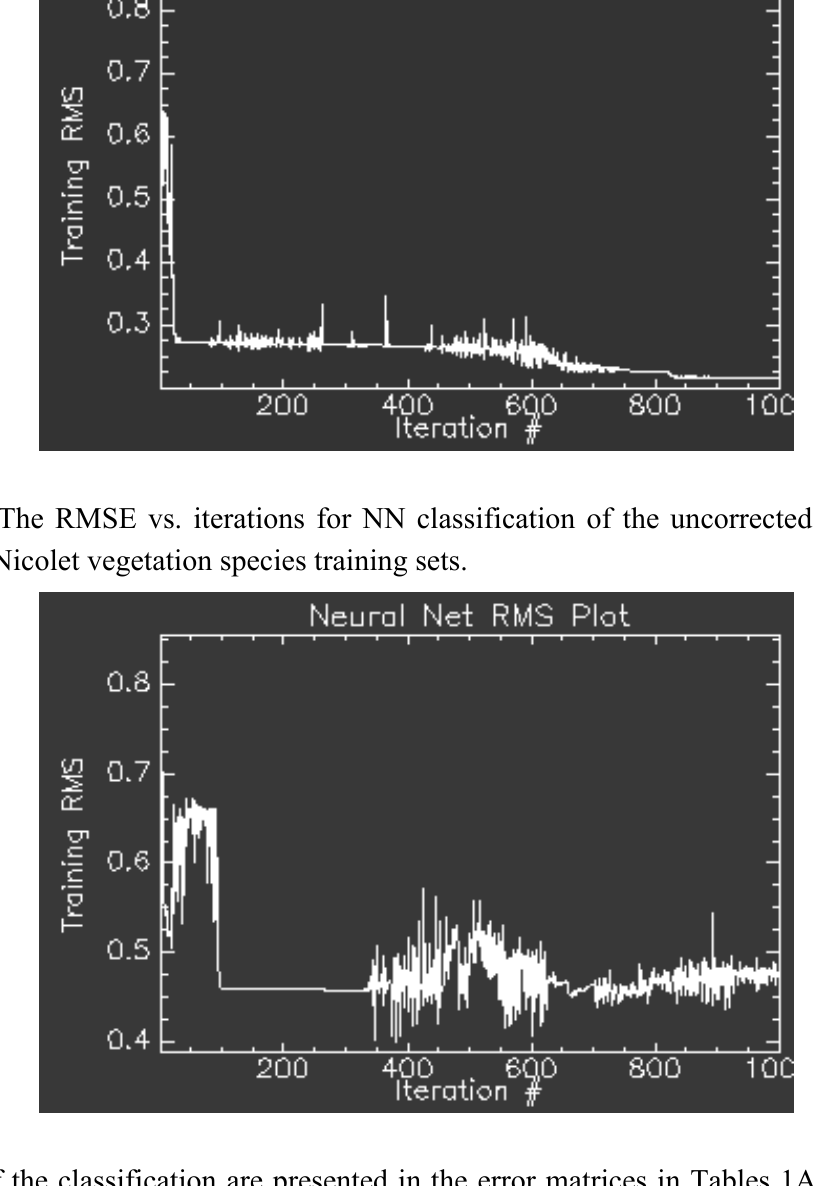
Figure 4. Using the correction scheme, the number of the off-diagonal misclassified pixels in error matrices were minimized and optimized relative to the aerosol model. The smaller the off-diagonal misclassified pixel values are, the higher the overall accuracy represented by the diagonal elements